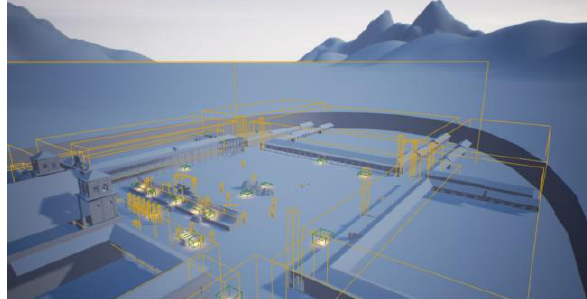
Figure. 1. Main Square of Santiago de los Caballeros, Guatemala, 1554. Unreal Engine, blocking boxes view.